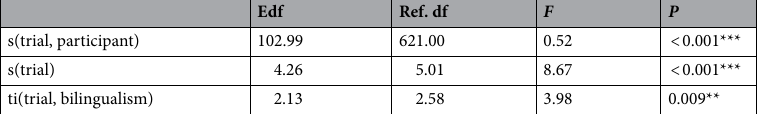
Table 3. Approximate significance of smooth terms (outcome variable: proportion of time looking at the changing stimulus). Parametric coefficient (intercept) = 0.55 ( SE = 0.01, t = 54.52, p < 0.001). GCV =